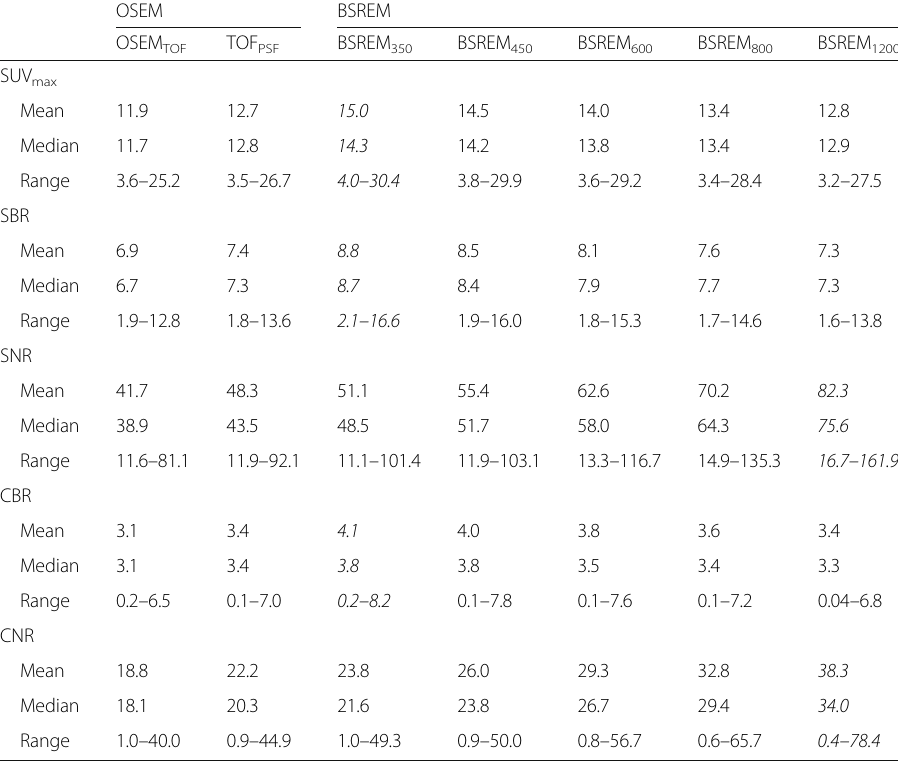
Table 4 Results of quantitative PET image assessment for different reconstruction algorithms including maximum standardized uptake value (SUV max ) of the primary lung tumor, tumor signal- to-background ratio (SBR), tumor signal-to-noise ratio (SNR), contrast-to-background ratio (CBR), and contrast-to-noise ratio (CNR). Italicized numbers are the reconstructed datasets yielding the highest values for given parameters OSEM BSREM OSEM TOF TOF